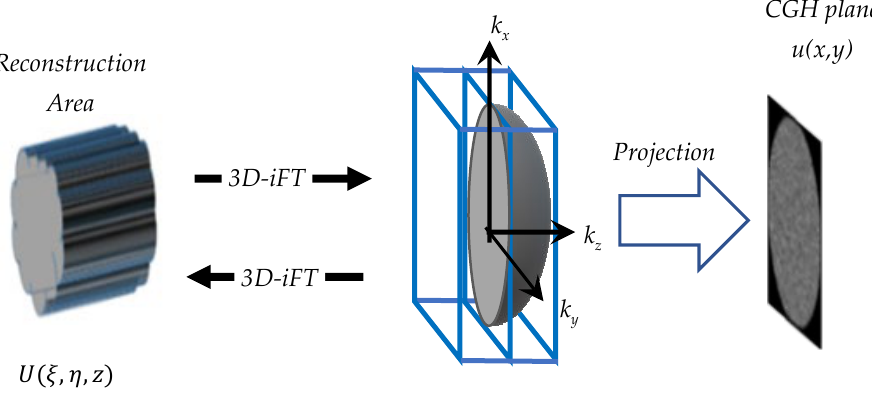
Figure 3. The scheme of 3D-GSA.